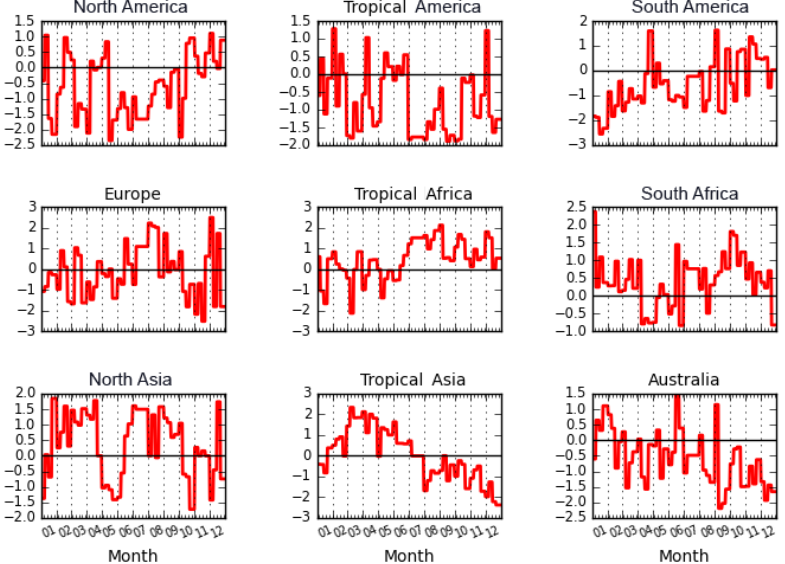
Figure 8. Time series of the standardized anomaly of the modelled NEE budget ( γ in Eq. 3) for crops in 2010 in the different regions. Positive values indicate larger/smaller CO 2 sources/sinks than normal based on the mean climatological budget; whereas negative values correspond to smaller/larger CO 2 sources/sinks than